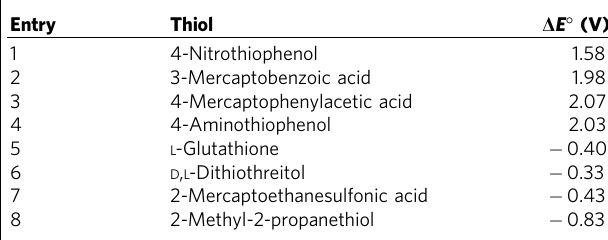
(Table 2, entries 1–4). For MPAA, the calculated D E (cid:2) of 2.07 V (Table 2, entry 3) indicates that disulfide radical anion formation Table 2 | Calculated redox potentials for disulfide radical anion formation from aliphatic and aromatic thiols at pH